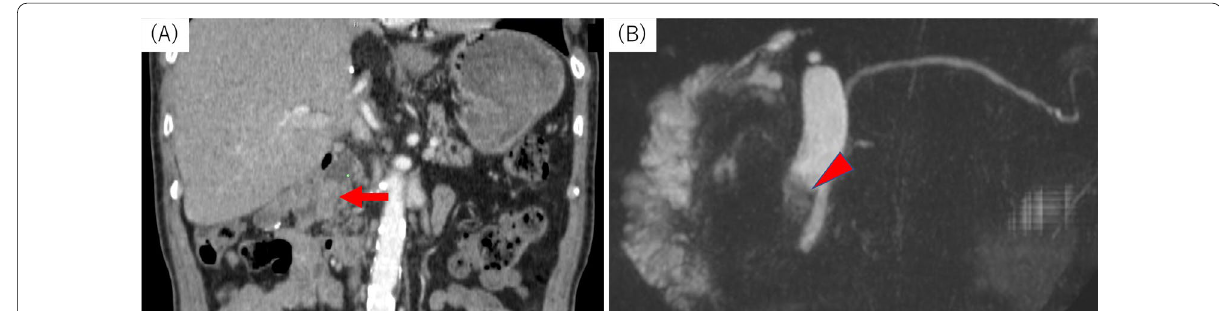
Fig. 5 Contrast-enhanced computed tomography and magnetic resonance cholangiopancreatography findings for the recurrent lesion. A Contrast-enhanced computed tomography findings revealed a 1.5-cm mass in the lower remnant common bile duct at 16 months after the first surgery (arrow). B Magnetic resonance cholangiopancreatography findings identified the tumor as a defect in the lower remnant common bile duct (arrowhead)